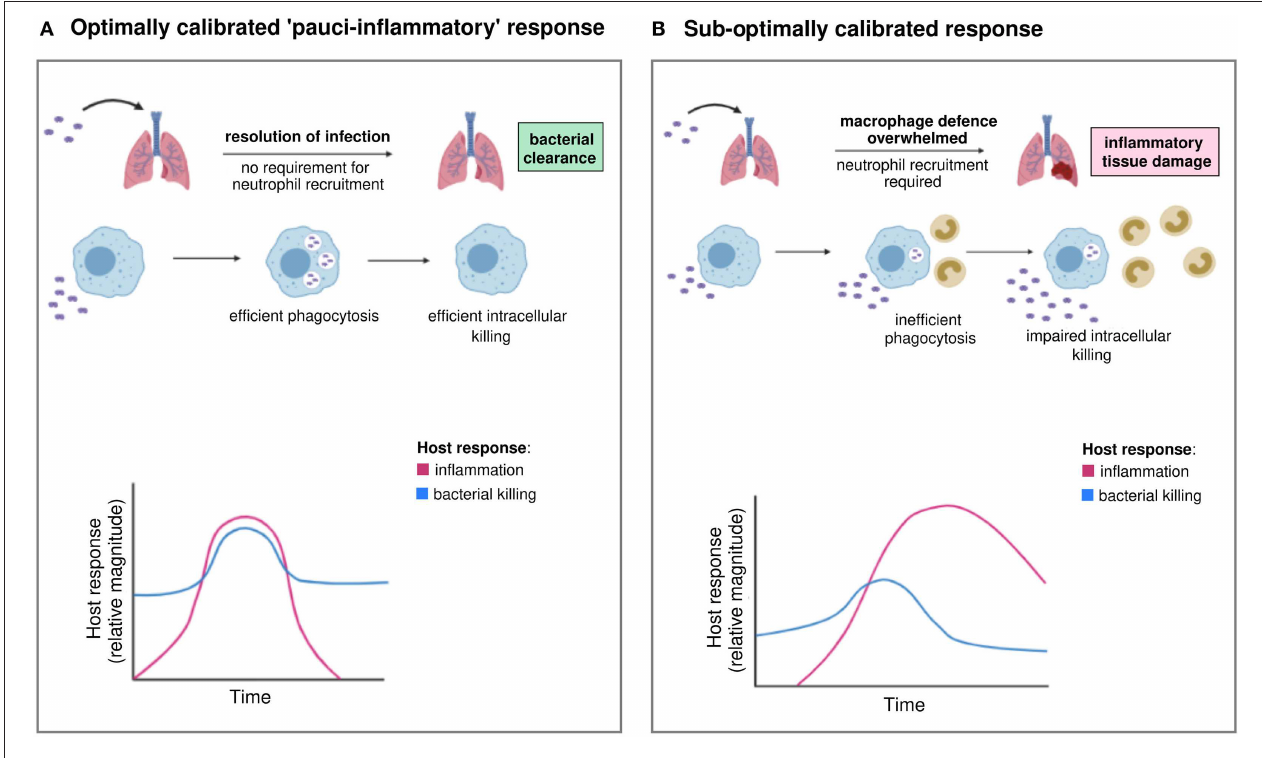
FIGURE 1 | Optimal and sub-optimal inflammatory and bacterial killing trajectories during infection. (A) Invading extracellular bacteria are recognized and phagocytosed by macrophages, followed by intracellular killing. Pathogen clearance is optimal and achieved without the requirement for neutrophil recruitment. Inflammation is tightly controlled and resolves without causing tissue damage. We term this optimally calibrated response “ pauci-inflammatory.” (B) In hosts with sub-optimally calibrated responses, there is inefficient phagocytosis and/or intracellular killing by macrophages, resulting in incomplete bacterial clearance. When macrophage defense is overwhelmed beyond a “tipping point,” neutrophil recruitment is required to control the invading pathogen. Inflammation is more prolonged and sustained by pathogen persistence and/or tissue damage. Inflammatory responses give rise to clinically recognizable features of disease, for example pneumonia. Images created using